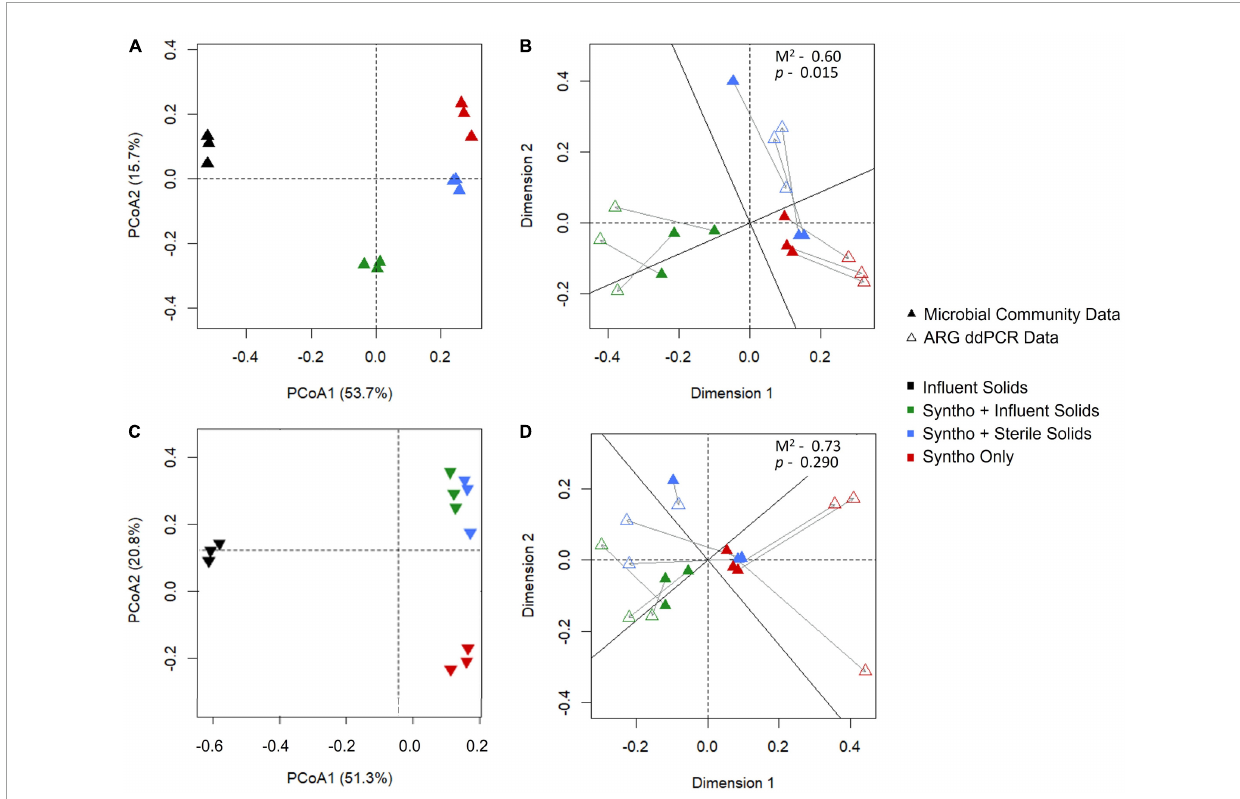
FIGURE3 Procrustes analysis to investigate the correlation between the microbial community and ARG composition. (A) Microbial community of the reactors visualized using Jaccard dissimilarity as determined by 16S rRNA gene sequencing. (B) Procrustes analysis of microbial communtiy and ARG profile with Jaccard dissimilarity. (C) Microbial community of the reactors visualized using Bray Curtis dissimilarity as determined by 16S rRNA gene sequencing. (D) Procrustes analysis of microbial communtiy and ARG profile with Bray Curtis